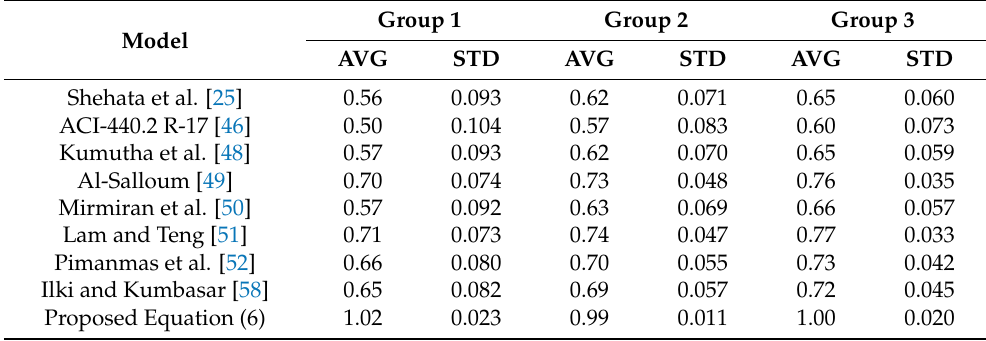
Table 5. Assessment of analytical models to predict peak compressive stress of FCSM confined CRA. Group 1 Group Model